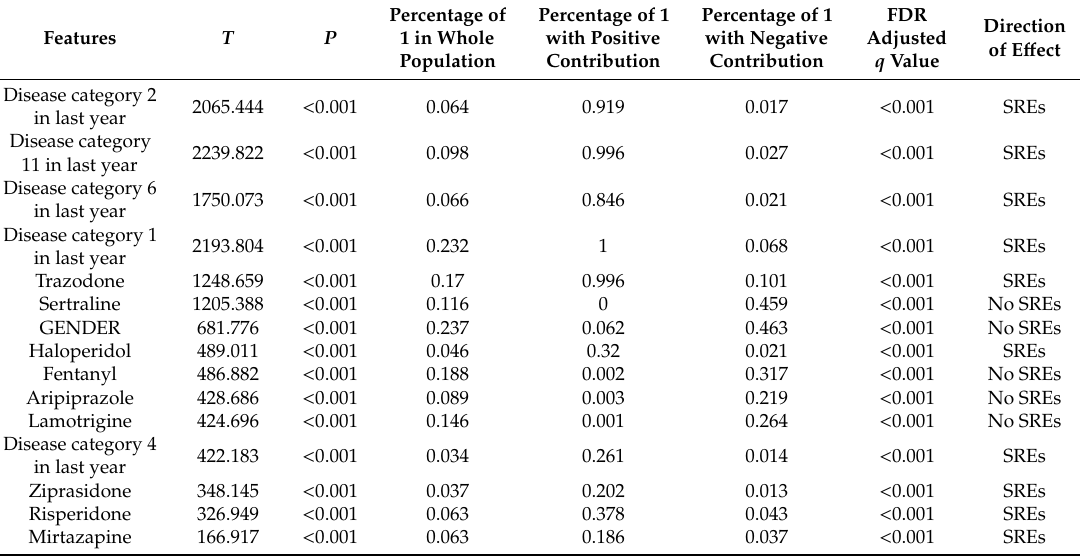
Figure 5. Distribution of feature values with positive and negative contributions. Most 0 values are associated with a higher risk of suicide and 1 are considered having lower risks. 0 means that the patients did not have the disease or did not take the medication and 1 means they did. Some features showed obvious separation in contributions by values which means the values of these features are strongly associated with the final prediction( CatN_1Year: Disease Category N in last year (N = 1, 2, 3, 4, 5, 6 and 11)). Table 5. Feature value distribution significance in positive and negative contributing